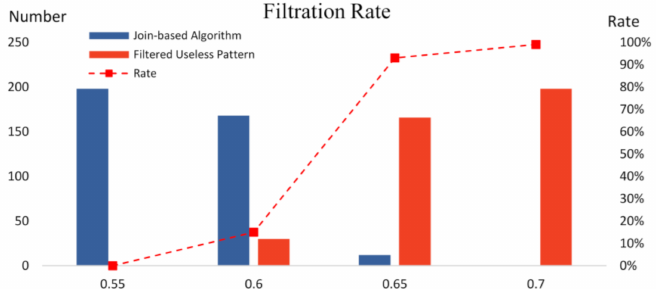
Figure 16. Filtration rate of connection algorithm for useless negative